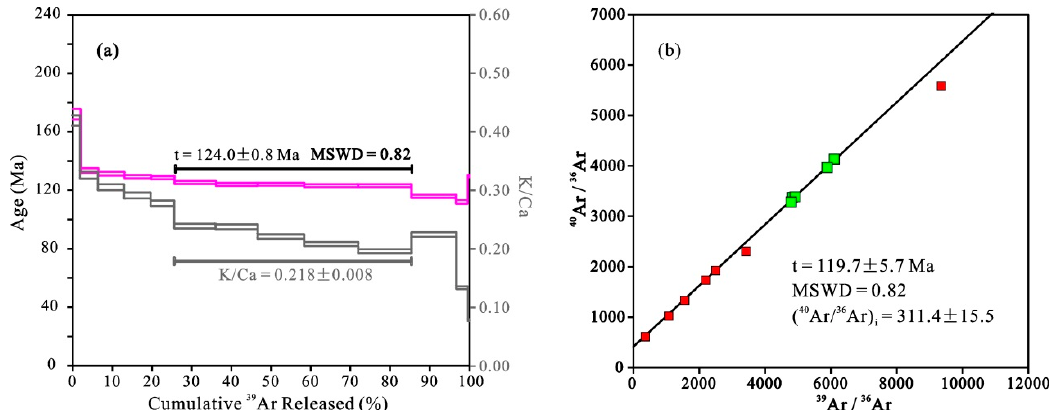
Figure 5. 40 Ar/ 39 Ar plateau age and K/Ca ratio spectra ( a ) and 40 Ar/ 36 Ar versus 39 Ar/ 36 Ar diagram ( b ) for whole ‐ rock NEB samples. Age uncertainties correspond to the 1 σ level. On the isochron plot, green squares represent the data used to determine the isochron.